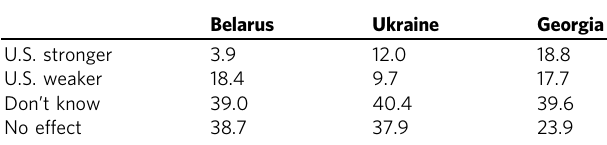
Table 1 Per cent responses to “ How do you think the Capitol riot will affect the role of the United States in global affairs ”